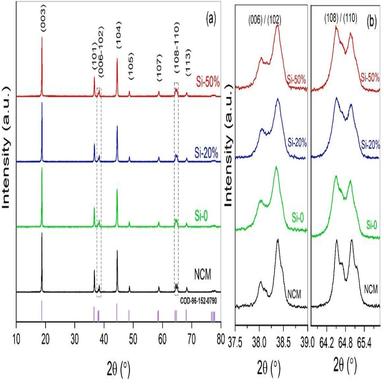
(a) XRD data of NCM, Si-0, Si-20 % and Si-50 % powders, (b) magnified XRD pattern of (006)/(102) and (108)/(110) peaks.